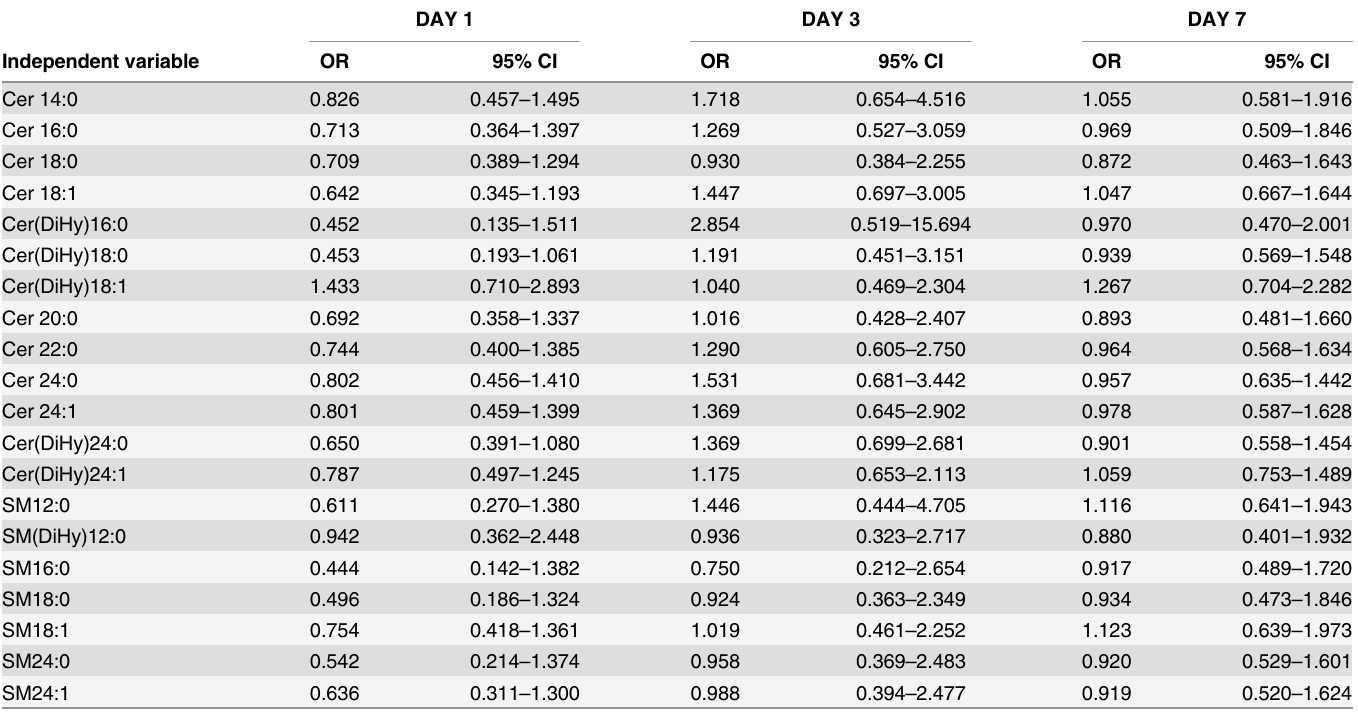
Table 3. Multivariable logistic regression analysis with outcome mortality/ development of